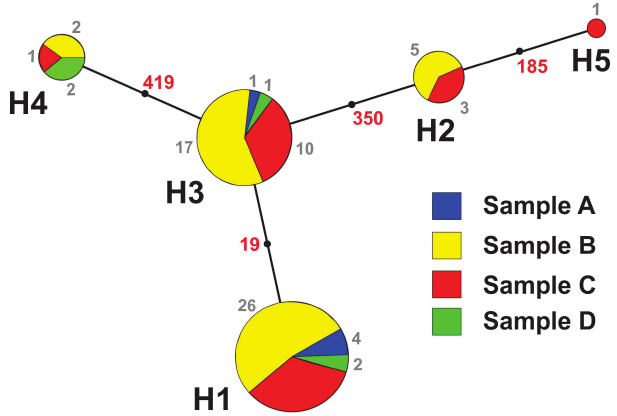
Fig. 3. Haplotype network based on partial sequencing of the D-loop region (mtDNA) of 92 individuals of Brycon nattereri from the Laranjinha River. Circle sizes are pro- portional to haplotype